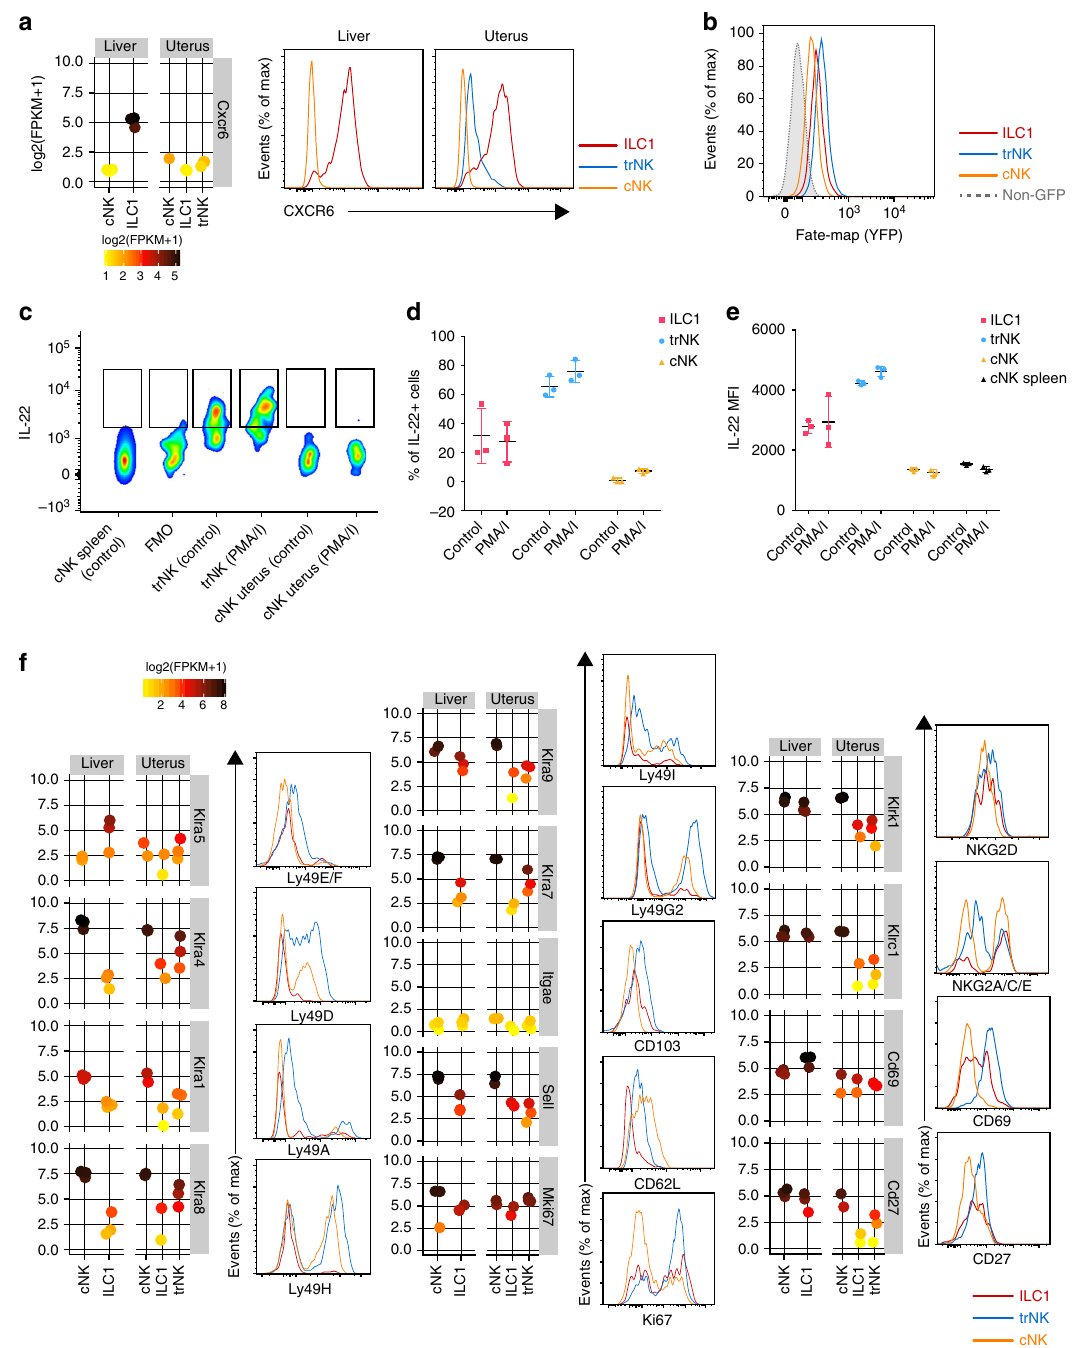
Fig. 4 Uterine g1 ILCs express CXCR6, IL22 and some cells are ex-ILC3s. a Individual gene expression plot showing expression of Cxcr6 in the liver and uterus. Scale represents log2(FPKM + 1) transformed normalised reads. Histograms are showing CXCR6 protein expression on g1 ILCs in both organs at mid-gestation. Red line-ILC1, blue line-trNK, orange line-cNK. G1 ILCs were gated as described in Fig. 1a. b Fate-mapping of g1 ILCs in the uterus of Rorc( γ t)- Cre TG /R26R females. c IL-22 production by uterine trNK and cNK at gd 9.5. Control wells were incubated with medium containing protein transport inhibitors only. d Quanti fi cation of the percentage of IL-22-producing cells in the uterus at gd 9.5. Error bars represent mean ± SD. e Quanti fi cation of the mean fl uorescence intensity of IL-22 on g1 ILCs at gd 9.5. Error bars represent mean ± SD. f Flow cytometry validation of various surface receptors on g1 ILCs in the uterus. Data are representative of three independent experiments. FPKM: fragments per kilobase of exon model per million reads mapped